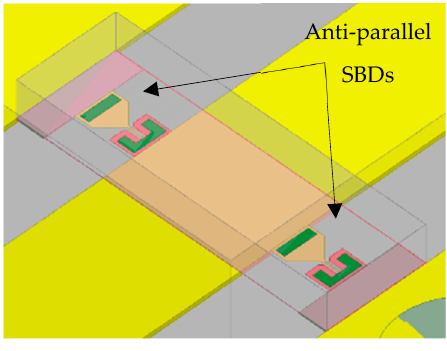
Figure 4. 3D perspective view of the modelled anti-parallel SBDs mounted on the copper ( yellow ) layer of substrate with CPW line.